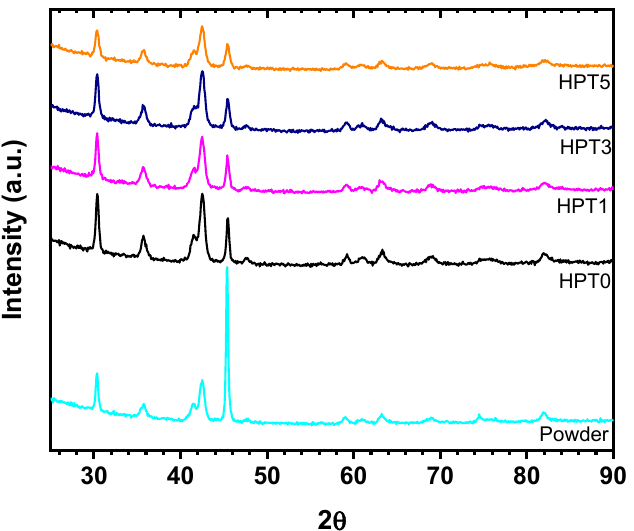
Figure 6. X-ray diffraction patterns of LaNi 5 at various stages: as-received powder (Powder), pressed pellet (HPT0) and pellet after 1, 3 and 5 HPT turns (HPT1, HPT3 and HPT5). The vertical lines indicate the position of LaNi 5 Bragg peaks.